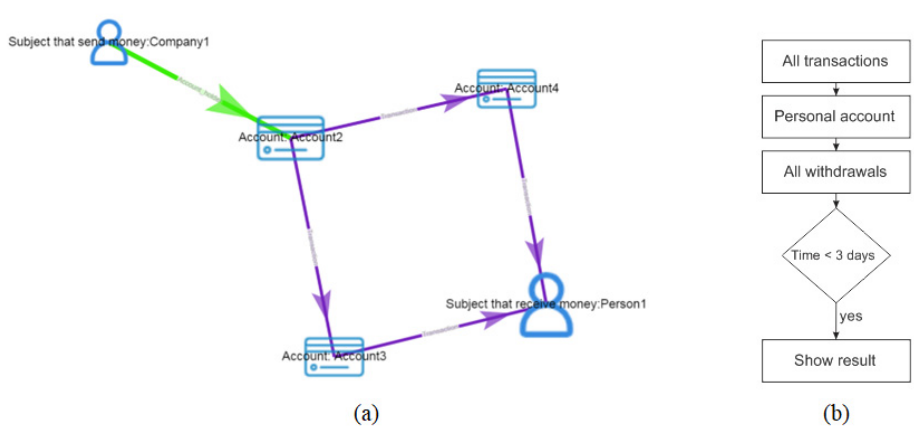
Figure 2. ( a ) The result of a query, where the green edge represents the initial suspicious transaction, and ( b ) the flowchart of the used Cypher query.